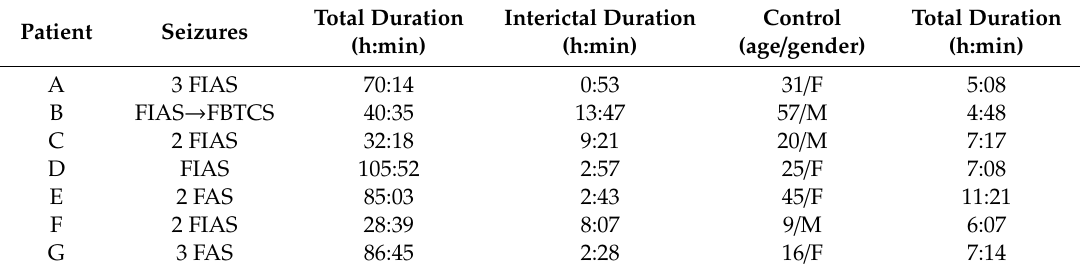
Table 2. Collected episodes. Seizures were focal-impaired awareness seizures (FIAS), focal to bilateral tonic–clonic seizures (FBTCS), and focal aware seizures (FAS). “FIAS → FBTCS” means that FIAS symptomatically changed to FBTCS, which was treated as a consecutive